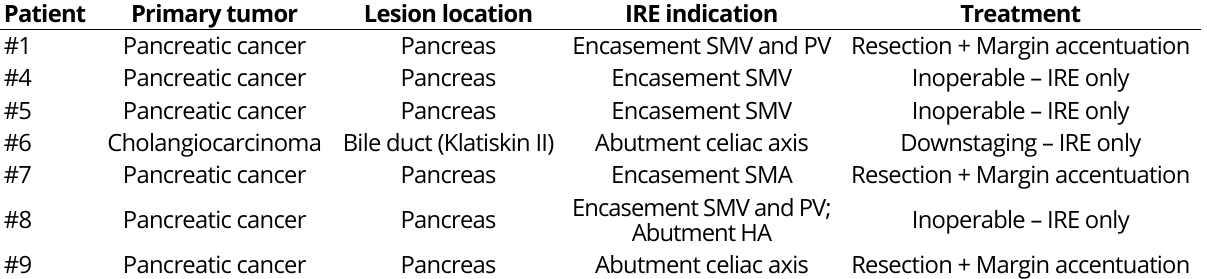
Table 2. Surgical IRE indication.